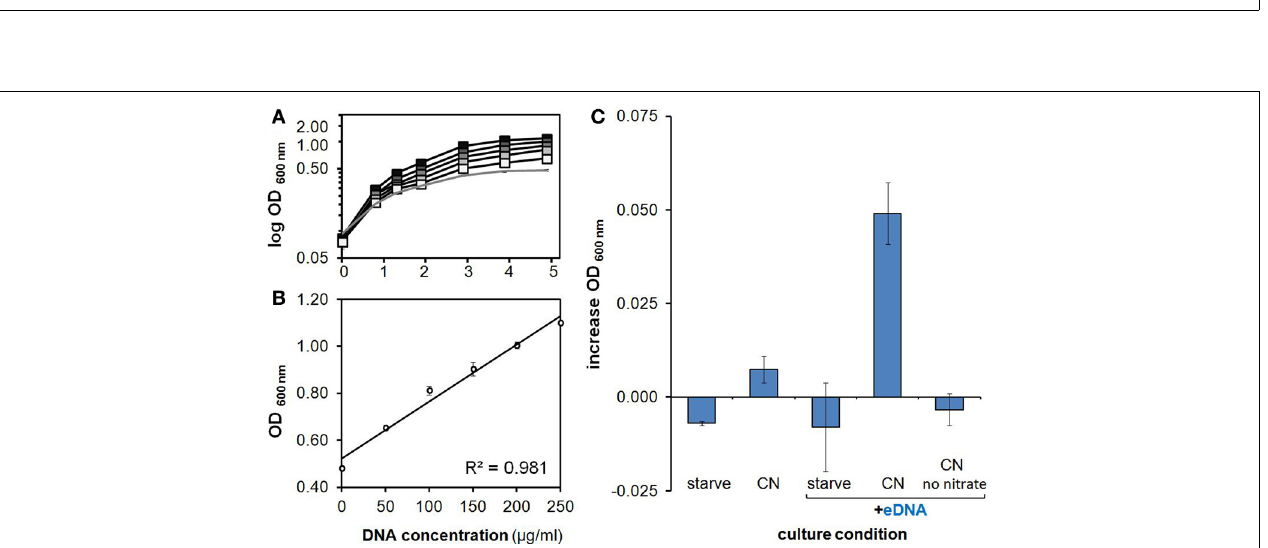
(solid lines) and baffled (dashed lines) flasks. A photograph of a representative replicate culture flask is also shown, with characteristic red color of halobacterial cells in dense cultures in the CNP control and CN + eDNA flasks. Error bars represent standard deviation of replicate cultures.